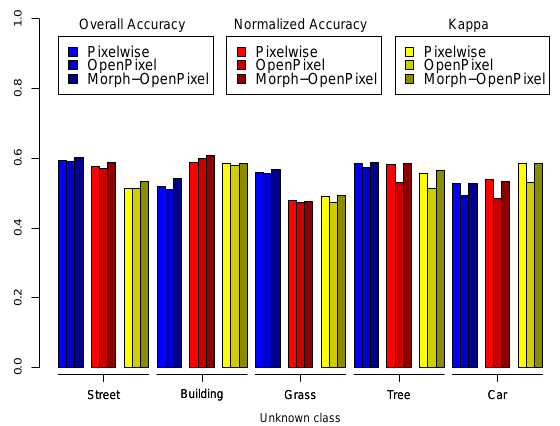
Figure 7. Overall Accuracy, Normalized Accuracy and Kappa Index obtained by the Pixelwise network and the proposed methods, OpenPixel and Morph-OpenPixel, for each unknown class in the experimental